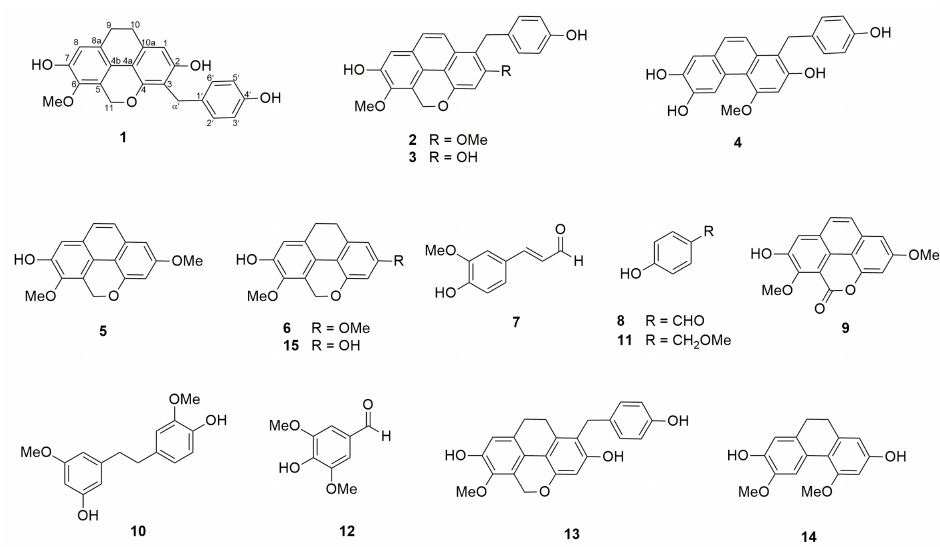
Figure 2. Chemical structures of compounds 1 – 15 . Compound 2 was isolated as a brown amorphous solid. The high-resolution APCI mass spectrum showed a protonated molecular ion [M + H] + at m/z 389.1351 (calculated for C 24 H 21 O 5 389.1389), suggesting the molecular formula C 24 H 20 O 5 . The UV spectrum of compound 2 (MeOH) showed maximum absorptions at 205, 225, 270, and 380 nm, which were similar to those of a phenanthopyran derivative [15]. The IR spectrum displayed strong absorption bands at 3360, 2921, 1658, and 1633 cm − 1 . The 1 H NMR spectrum (Table 1) exhibited aromatic protons with ortho -coupling at δ 7.55 (1H, d, J = 9.3 Hz, H-9) and 7.78 (1H, d, J = 9.3 Hz, H-10), and aromatic protons at δ 6.91 (1H, s, H-3) and 7.25 (1H, s, H-8). A pair of oxymethylene protons appeared at δ 5.64 (2H, s, H 2 -11), indicating the presence of a phenanthropyran structure. Moreover, resonances for two methoxy groups were observed at δ 3.94 (3H, s, 2-OMe) and 3.93 (3H, s, 6-OMe). Additional signals for a pair of methylene protons at 4.29 (2H, s, H 2 - α (cid:48) ) and two pairs of two-proton doublets at δ 7.01 (2H, d, J = 8.4 Hz, H-2 (cid:48) , H-6 (cid:48) ) and 6.66 (2H, d, J = 8.4 Hz, H-3 (cid:48) , H-5 (cid:48) ) suggested the presence of a p -hydroxybenzyl moiety, which should be located at C-1, as evidenced by the 3-bond coupling between H-2 (cid:48) /H-6 (cid:48) and C- α (cid:48) ( δ 28.9). The HMBC connectivities from H 2 - α (cid:48) ( δ 4.29) to C-2 ( δ 156.2), C-10a ( δ 129.5), and C-2 (cid:48) /6 (cid:48) ( δ 129.0) supported the position of the p -hydroxybenzyl moiety at C-1. In support of this, NOESY correlations (Figure 3) were found from H 2 - α (cid:48) ( δ 4.29) to H-2 (cid:48) /H6 (cid:48) and H-10. The methoxy